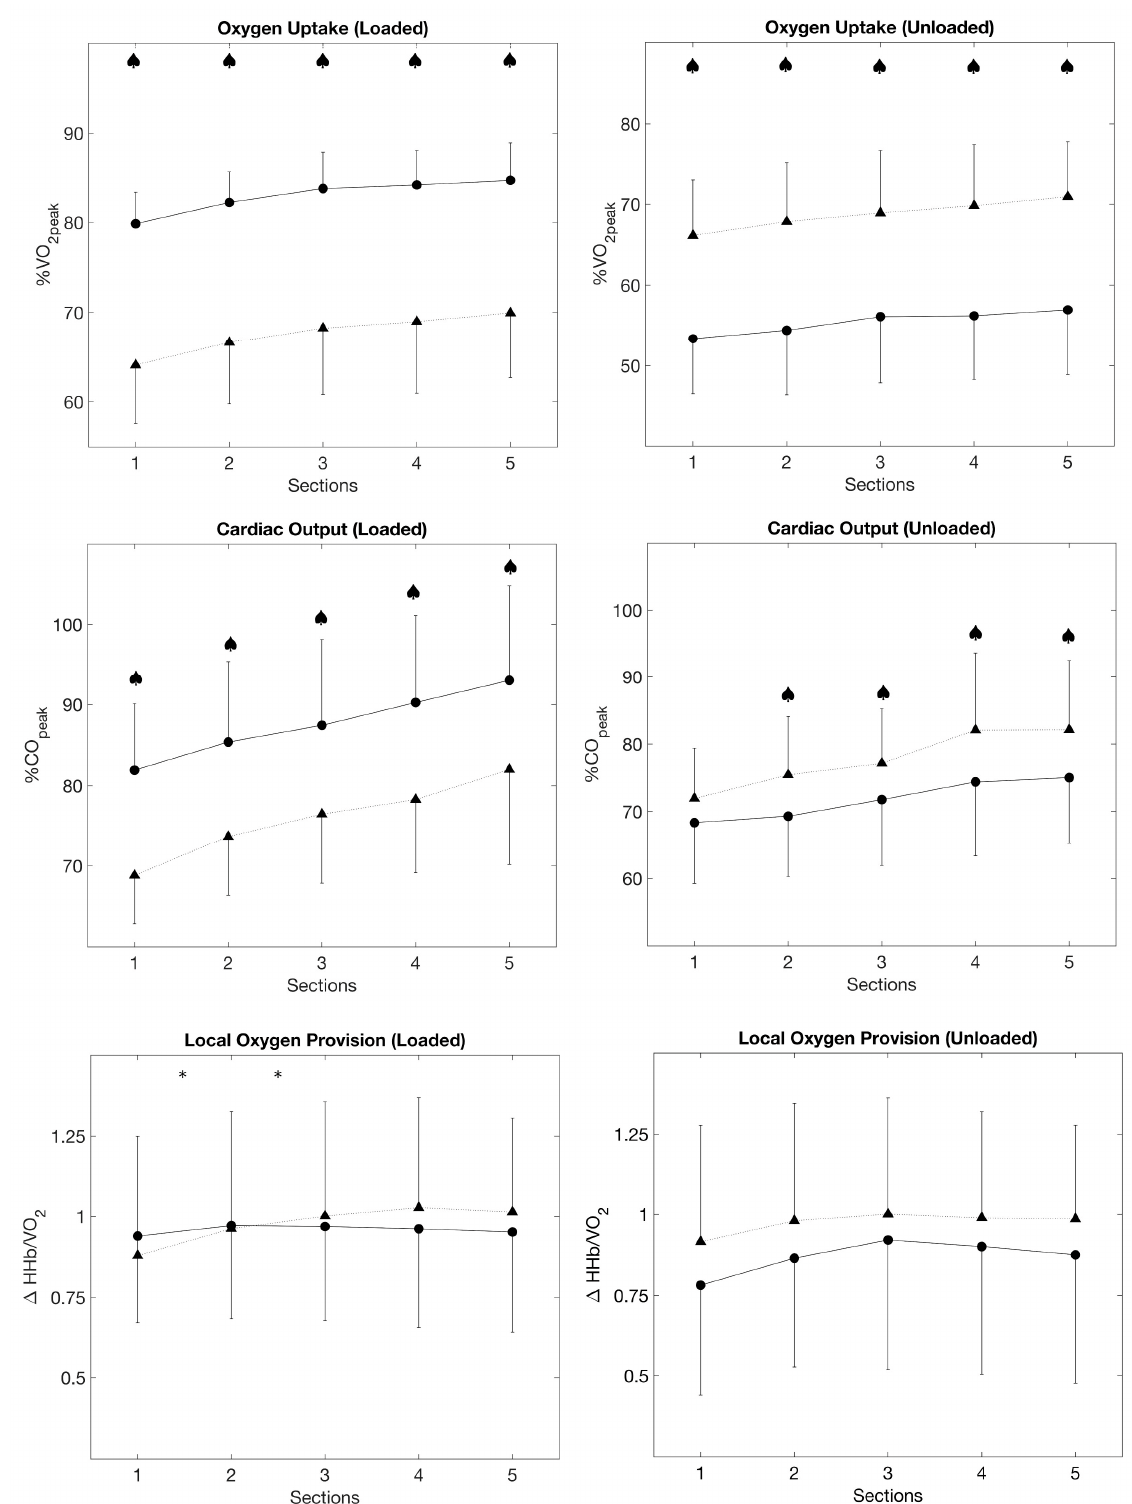
Figure 3. Averaged values for oxygen uptake, cardiac output and HHbVO 2 at the end of loaded and unloaded phases for HIIT3m ( • , solid line) and HIIT30s ( (cid:78) , dashed line); ♠ indicates significant differences between both protocols ( p ≤ 0.05); significant interaction effects are marked with * ( p ≤